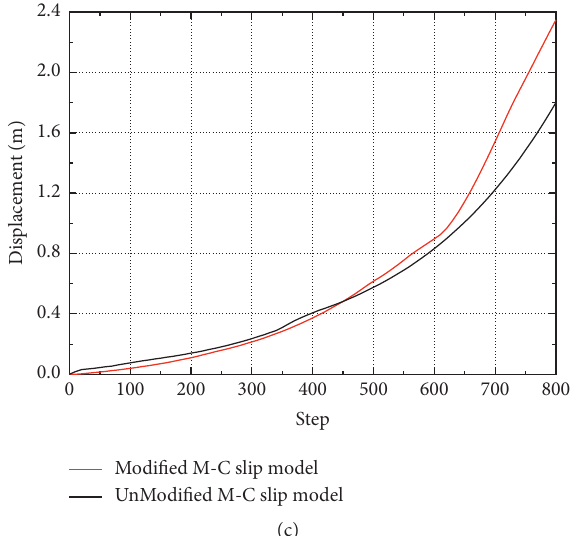
Figure 10: Rocky block slide-monitoring curves. (a) Block position monitoring curves with unmodified M-C slip model. (b) Block position monitoring curves with modified M-C slip model. (c) No. 2 block slip contrast